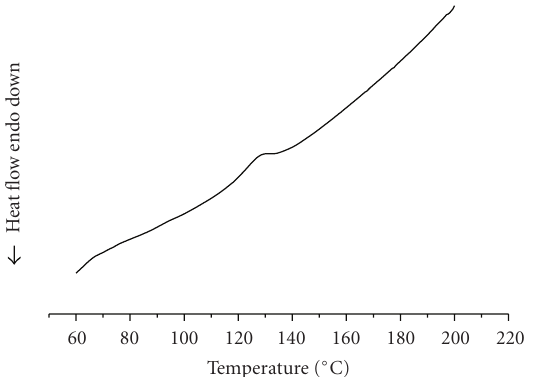
Figure 2: Calorimetric trace of virgin samples of POC(8,4), as obtained from the synthesis, first heating run.